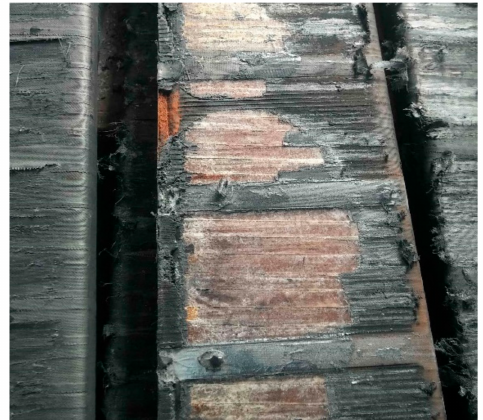
Figure 1. Electrical Erosion (2012)—Stator Bars.